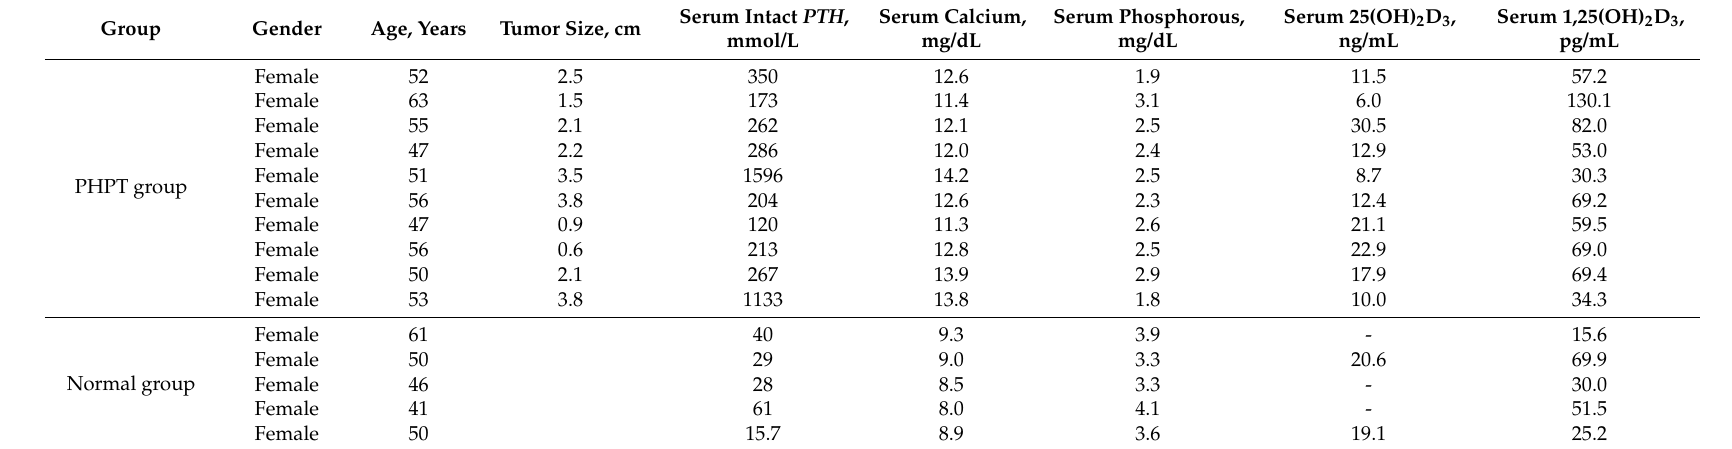
Table 1. Characteristics of the study subjects.